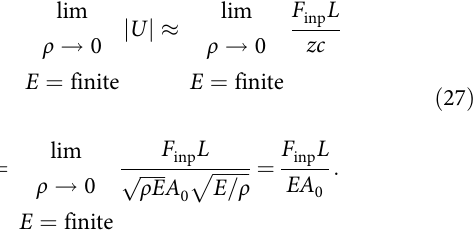
Figure 3a, b show the behaviors of S = S f T of the excitation frequency f . Note that, because ρ and E behave identically as functions of the frequency, the phase velocity remains unchanged. It is shown in Fig. 3b that z / z 0 approaches zero as the frequency f approaches to f R